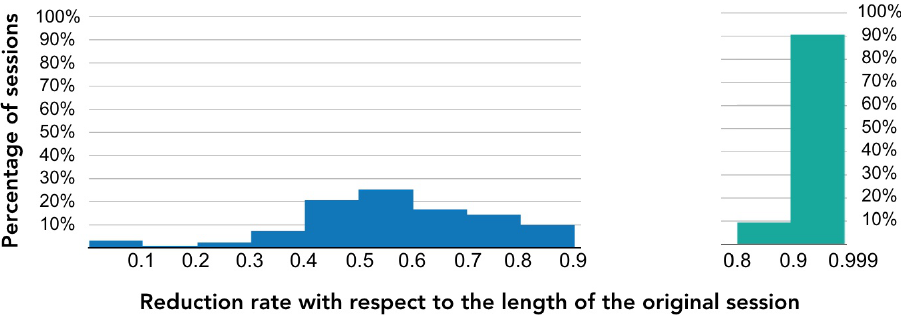
Figure 5. Histogram of the reduction rate of visitors from the class “Made payment”. The reduction rate is calculated with respect to the length of the original session. The blue histogram corresponds to the shrinked sessions; their reduction rate varies from 0 to almost 1. The green histogram corresponds to the stripped sessions; their reduction rate varies from 0.8 to almost